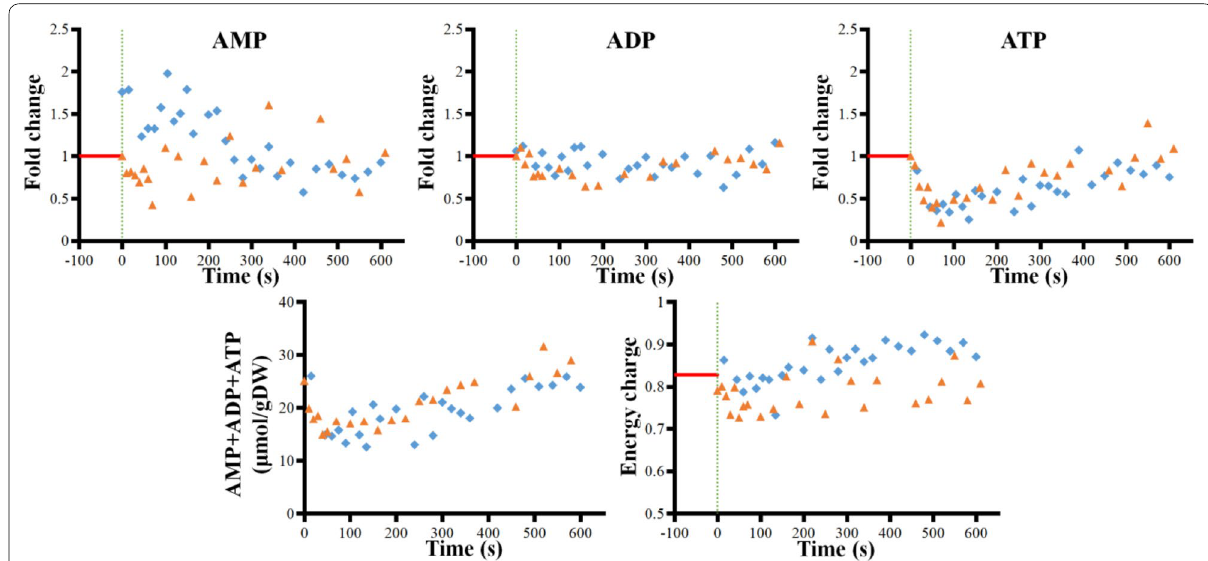
Fig. 8 Changes of nucleotides in the first 10 min after the glucose pulses. Fold change of AMP, ADP and ATP of the 0.90 g/L glucose pulse experiment (closed lozenges) and the 0.11 g/L glucose pulse experiment (closed triangles). Vertical hashed lines represent the start of the glucose pulse. The steady-state level is represented as red horizontal